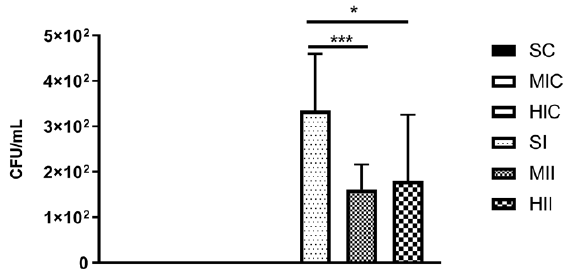
Figure 1. Bacterial load on exercised and sedentary animals. A / J mice were challenged with the number of 10 8 CFU of MRSA strains. Animals were euthanized 72 hours post-infection. Animals had the lymph nodes macerated and cultured in BHI medium (Brain Heart Infusion). CFUs were quantified after 24 hours of culture; (MRSA: Methicillin-resistant Staphylococcus aureus ). CFU- colony forming unit; SC- sedentary control; MIC- moderate intensity control; HIC- high intensity control; SI- sedentary infected; MII- moderate intensity infected; HII- high intensity infected. n = 8 to 10 / group. *p<0.05; ***